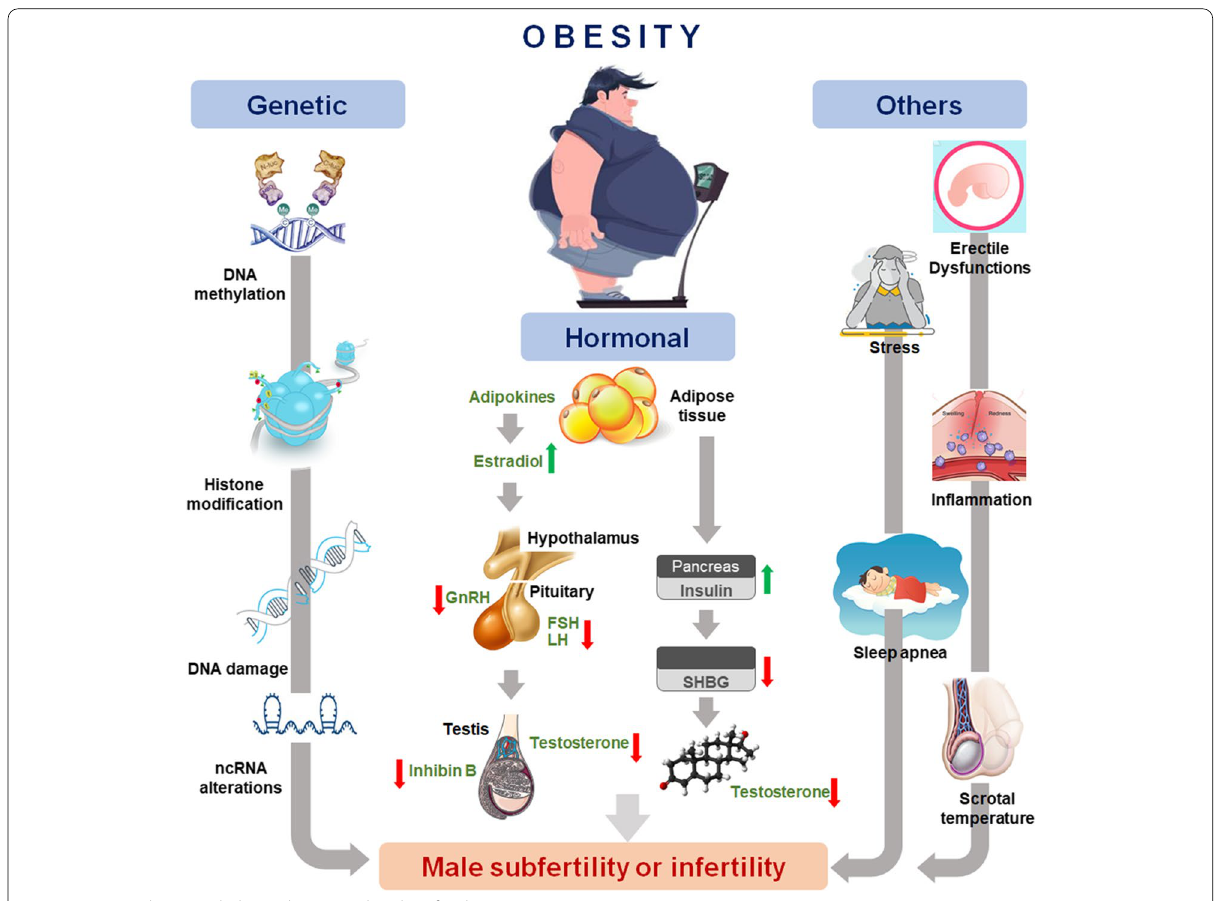
Fig. 1 Key mechanisms linking obesity and male